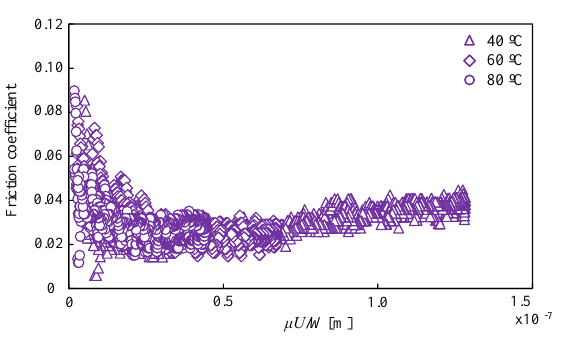
Fig. 10. Stribeck diagram in combination of micro dimple and MoS 2 shot treatments (1000 rpm)